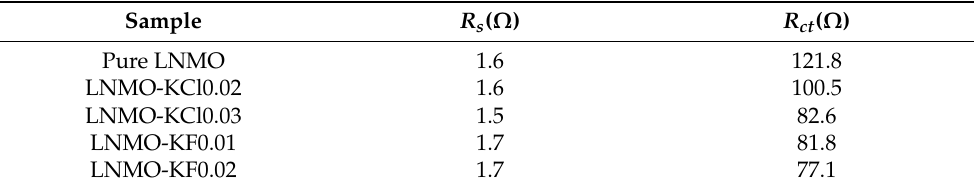
Figure 10. EIS curves (Nyquist plots) and the equivalent circuit (inset) for all samples after 200 cycles at 2C. Table 6. The values of R s and R ct of all samples after 200 cycles at 2C.